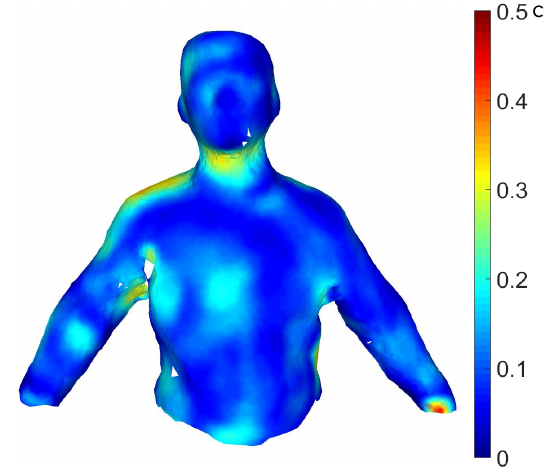
Figure 8. The error map of deforming some body parts of the